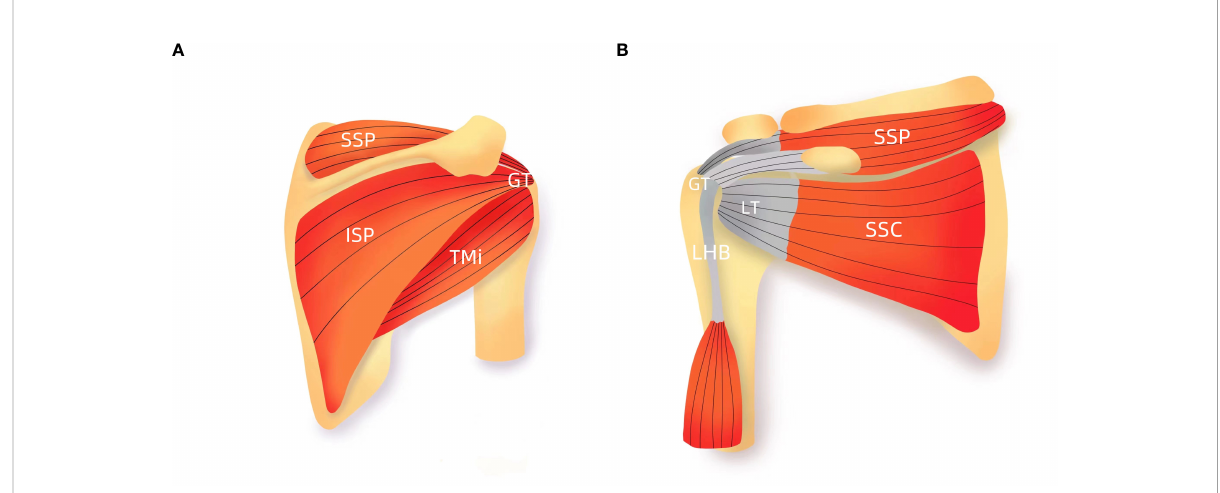
FIGURE 5 Schematic presentation of rotator cuff (A) Anterior view; (B) posterior view. GT, greater tuberosity; LT, lesser tuberosity; SSC, subscapularis; SSP, supraspinatus; ISP, infraspinatus; TMi, teres minor; LHB, the long head biceps